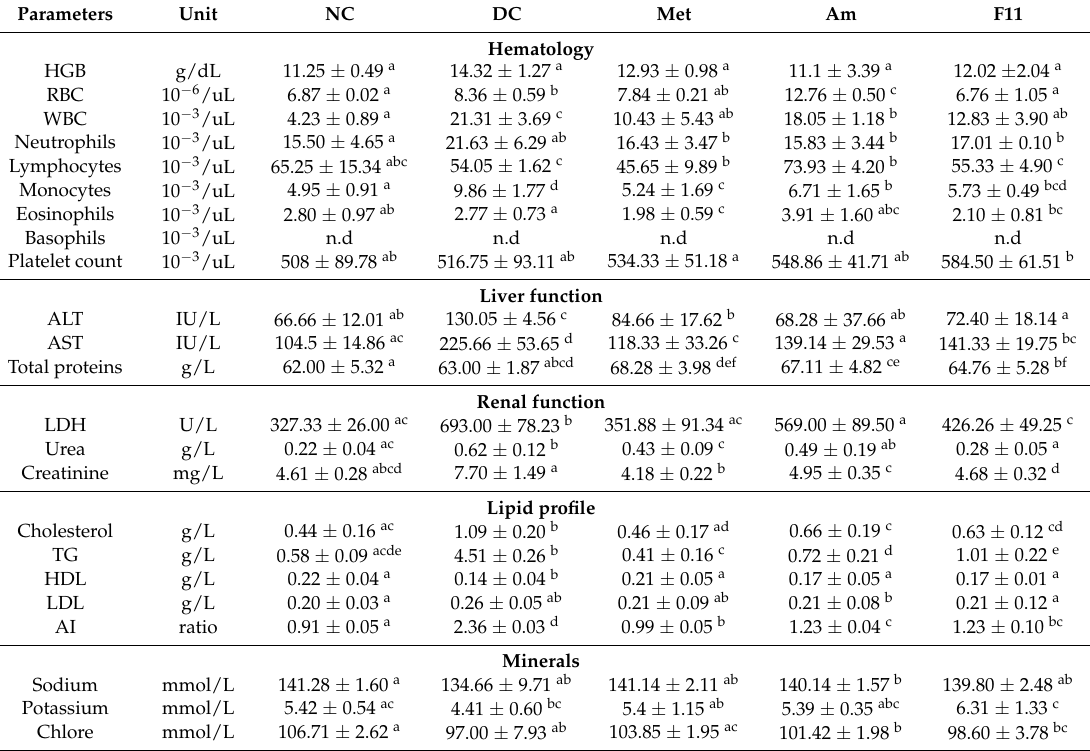
Table 3. Hematological and biochemical analysis of diabetic